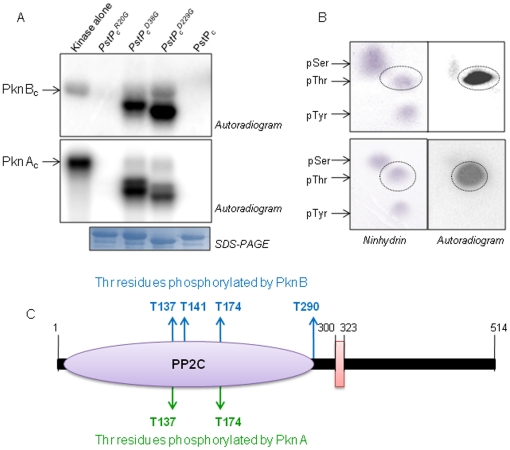
Phosphorylation of PstPc and its mutants by PknA andPknB.(A) Phosphorylation of PstPc and its mutants (3µg each) by 2 µg PknBc (upper panel) and 0.5µg PknAc (middle panel).PstPcD38G and PstPcD229Gwere efficiently phosphorylated by both the kinases due to loss ofphosphatase activity. Phosphorylation on PstPcR20Gmutant was low due to its partial phosphatase activity. Thecorresponding SDS-PAGE is shown (lowest panel) as a loading control.(B) Phosphoamino acid analysis by 2D-TLE illustratesthat both PknAc (upper panel) and PknBc (lowerpanel) phosphorylates PstPcD38G on Thr residues.(C) Sites of phosphorylation of PknBc (blue)and PknAc (green) in PstPcD38G wereidentified by mass spectrometric analysis. PknBcphosphorylates PstPcD38G majorly on four Thrresidues-Thr137, Thr141, Thr174 andThr290 while two Thr residues were phosphorylated byPknAc-Thr137 and Thr174.